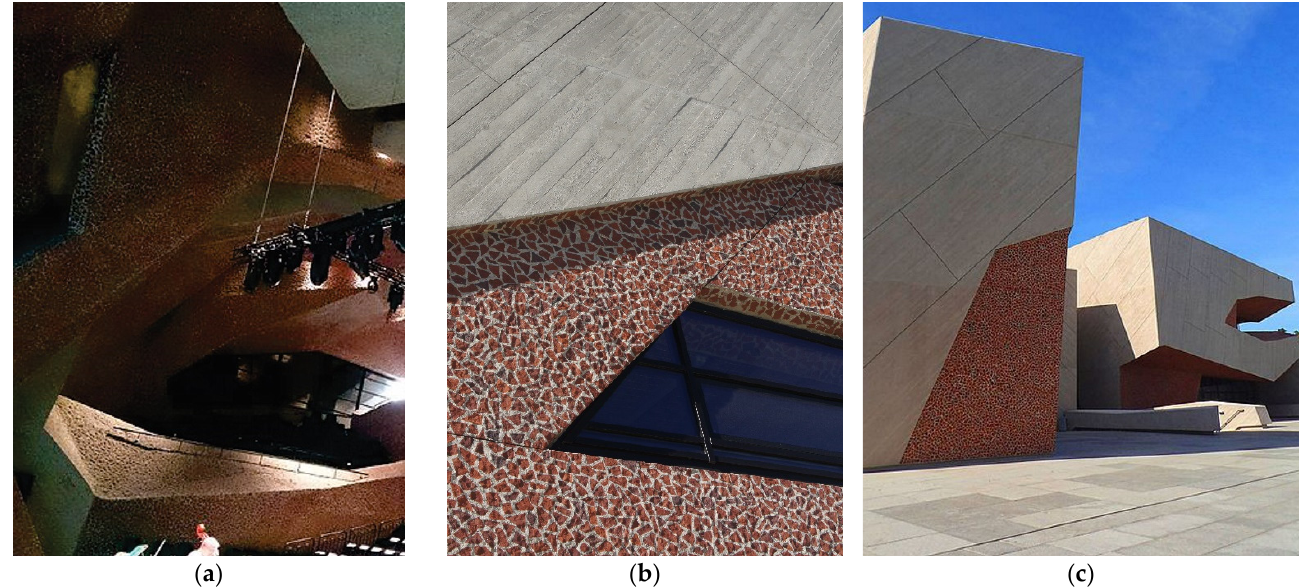
Figure 1. CKK Jordanki Congress and Culture Centre, Toru ń , 2015, arch. Menis Arquitectos. ( a ) Interior cladding with concrete-brick conglomerate panels. Source: https://pl.m.wikipedia.org/wiki/Plik:Auditorium_of_Conference_and_Cultural_Centre_%22Jordanki%22,_Toru%C5%84,_Poland.jpg (accessed on 31 May 2021) , photo by M. Sulik. ( b ) Exterior wall cladding with picado technique, (photo by M. Celadyn). ( c ) Exterior view. Source: https://commons. wikimedia.org/wiki/File:Centrum_Kulturalno-Kongresowe_Jordanki_w_Toruniu92.jpg,photo (accessed on 31 May 2021) by